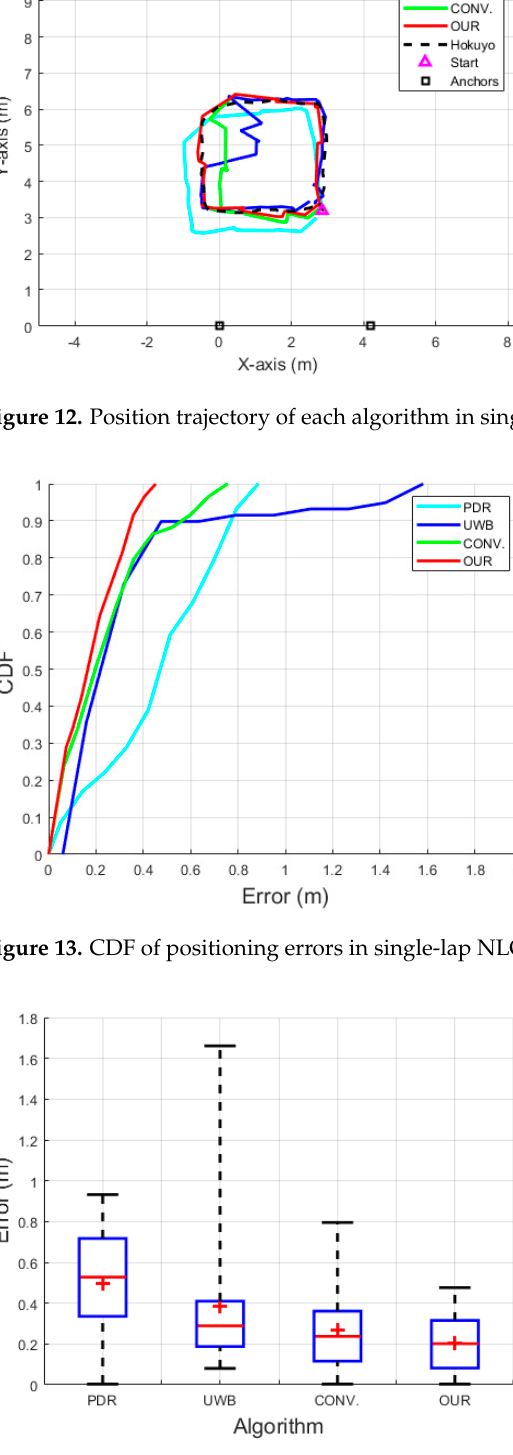
Figure 14. Box plot of positioning errors in single-lap NLOS scenario. Table 3. Positioning errors in single-lap NLOS scenario.